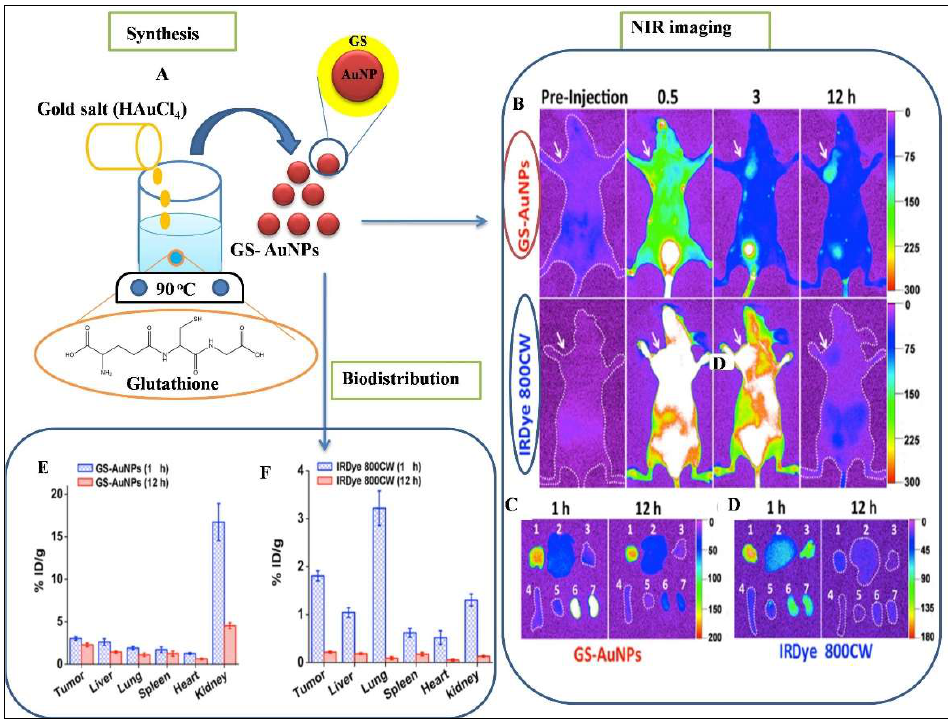
Figure 4. Gold nanocluster capped with glutathione (GS) (2.5 nm) for tumor imaging. ( A ) Gold nanocluster synthesis using GS as a capping agent. ( B ) NIR-dependent imaging in MCF tumor- bearing mice with glutathione capped gold nanocluster (GS-AuNCs) and standard dye (IRDye 800 CW) at the period of 0.5, 3, and 12 h. ( C ) and ( D ) showed ex vivo fluorescent images of organs and tumor removed at 1 and 12 h from the mice exposed to GS-AuNCs and IRDye 800CW, respectively. Labels: 1, tumor; 2, liver; 3, lungs; 4, spleen; 5, heart; 6, kidney (left); 7, kidney (right). ( E ) and ( F ) showed biodistribution of nanocluster and dye in different organs, respectively. Adapted from ref. [183] with permission. Copyright@American Chemical Society.